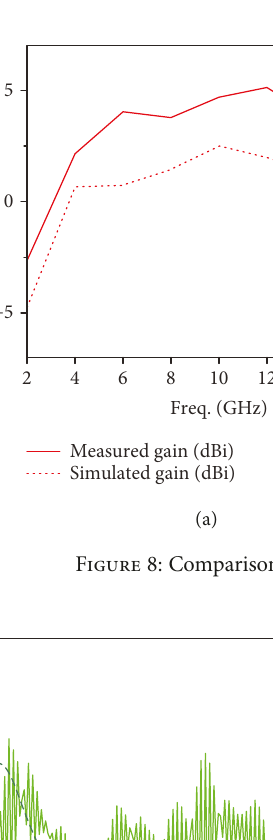
Figure 7: 3D model and fabricated proposed spiral antenna.